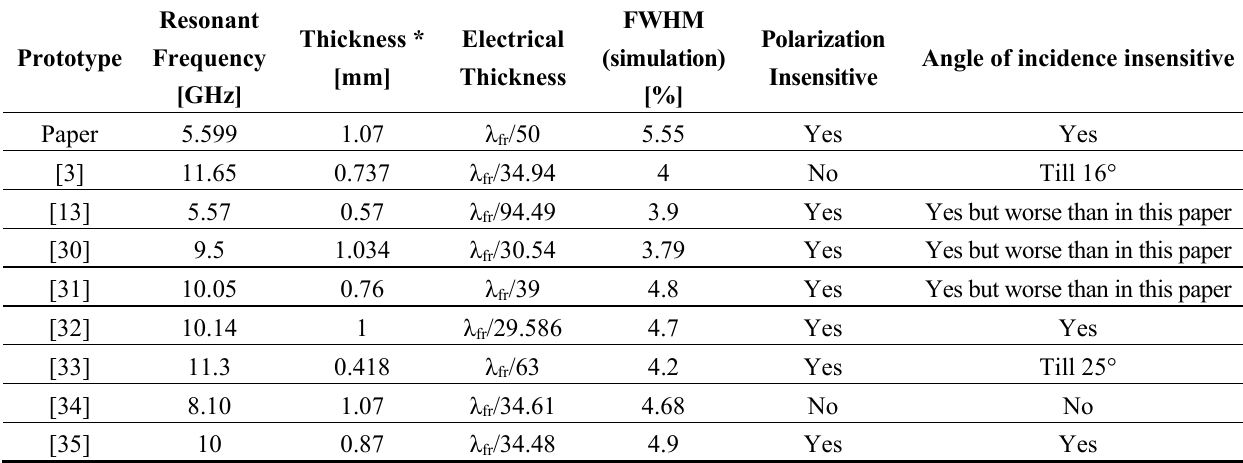
Table 1. Metamaterial absorber (MMA)